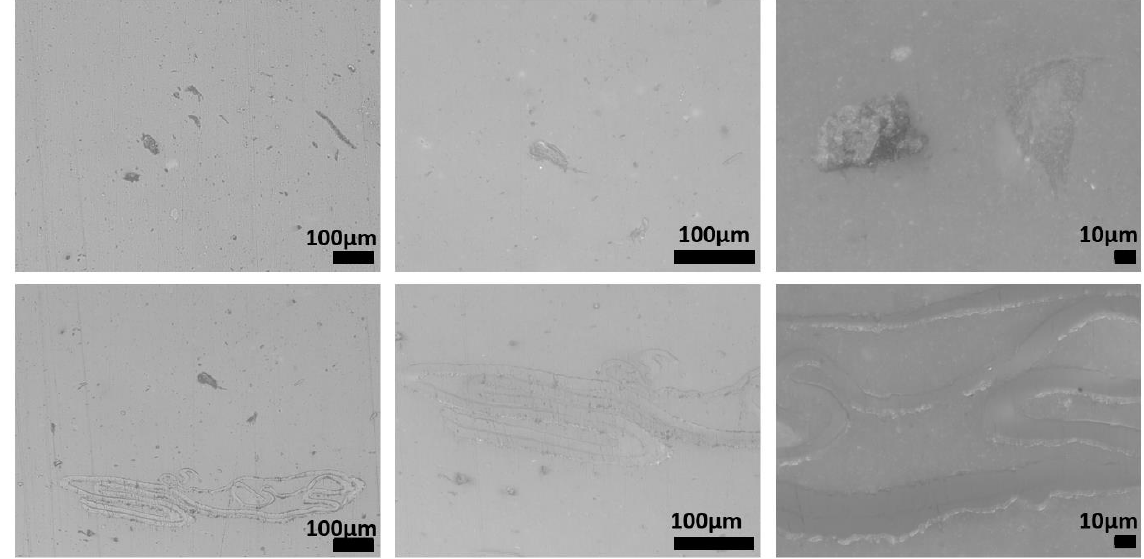
Figure 9. Microstructure of specimens produced using recovered PP.